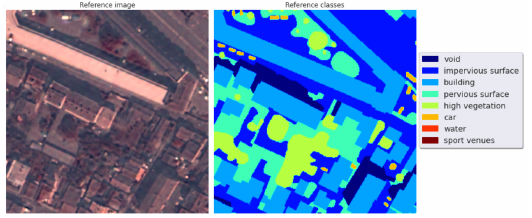
Figure 6. Example tile from the Toulouse dataset: image and labels.